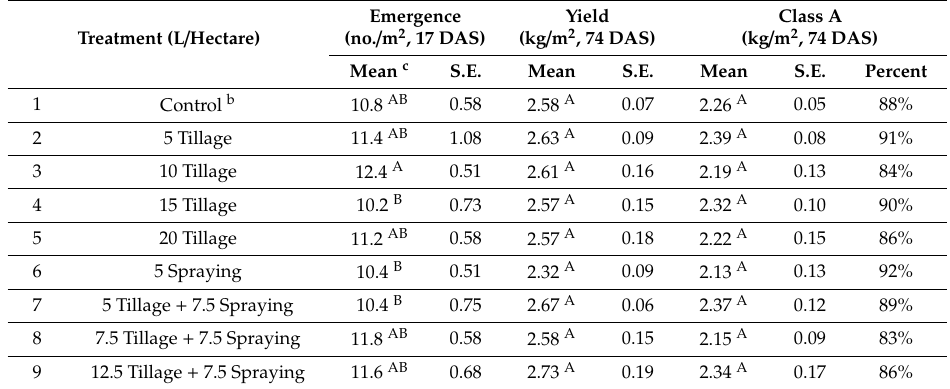
Table 5. The e ffi ciency of the Azoxystrobin spraying during and after land tillage (Neot Mordechai, spring 2018) a